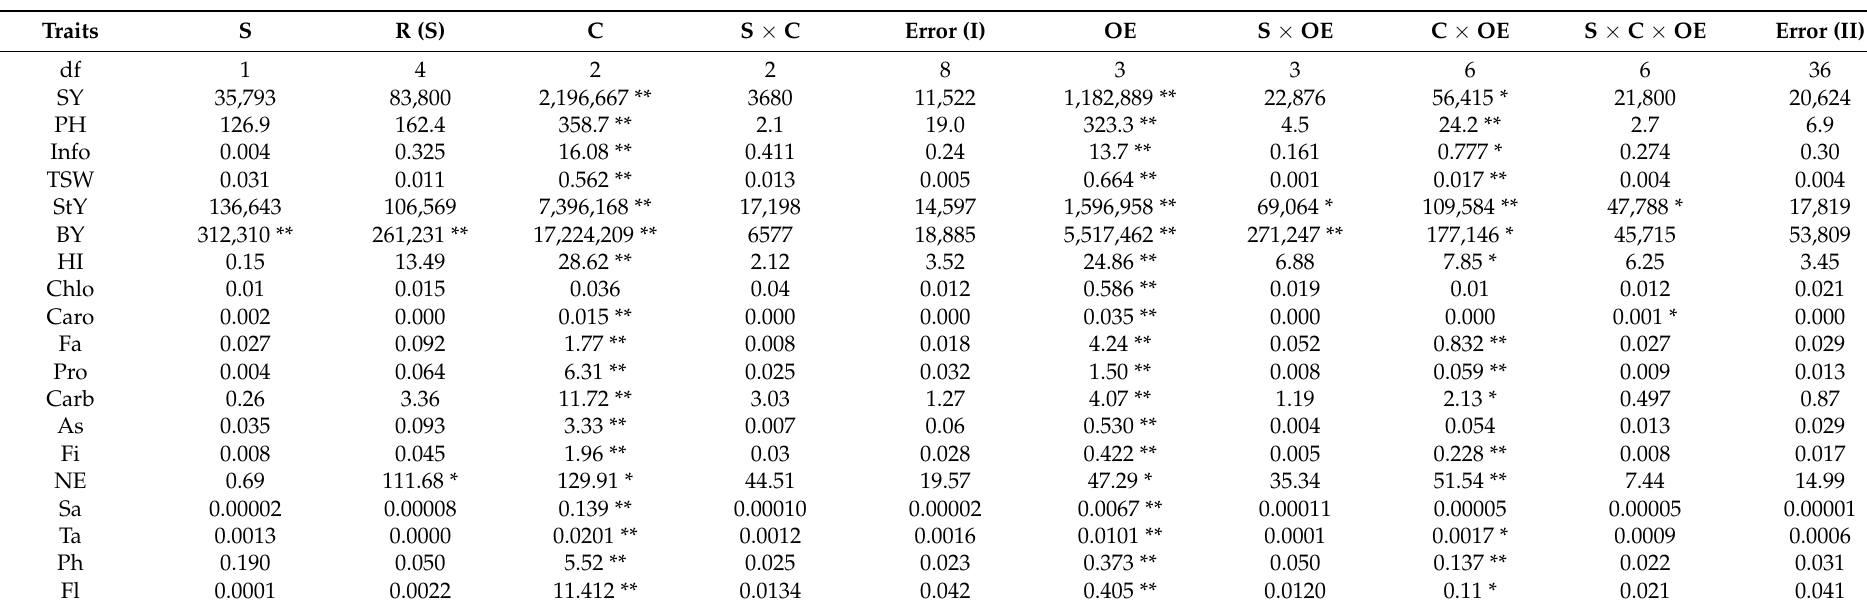
Table 3. Mean squares of source of variation for combined analysis of variance on studied traits of quinoa cultivars (C) and the organic extracts (OE) tested for two seasons (S). Traits